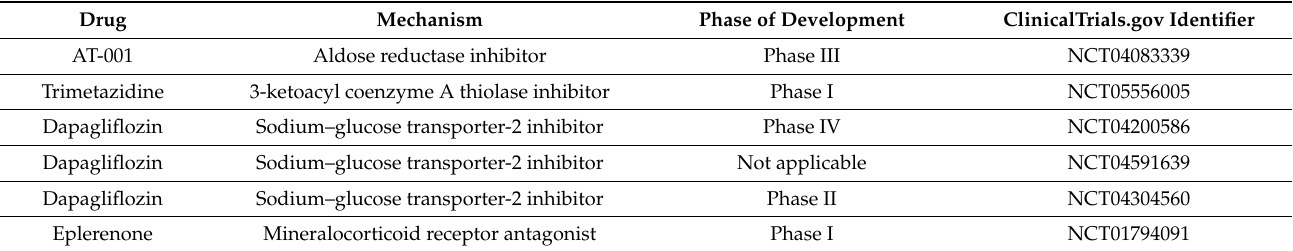
Table 4. Ongoing clinical trials for the treatment of diabetic